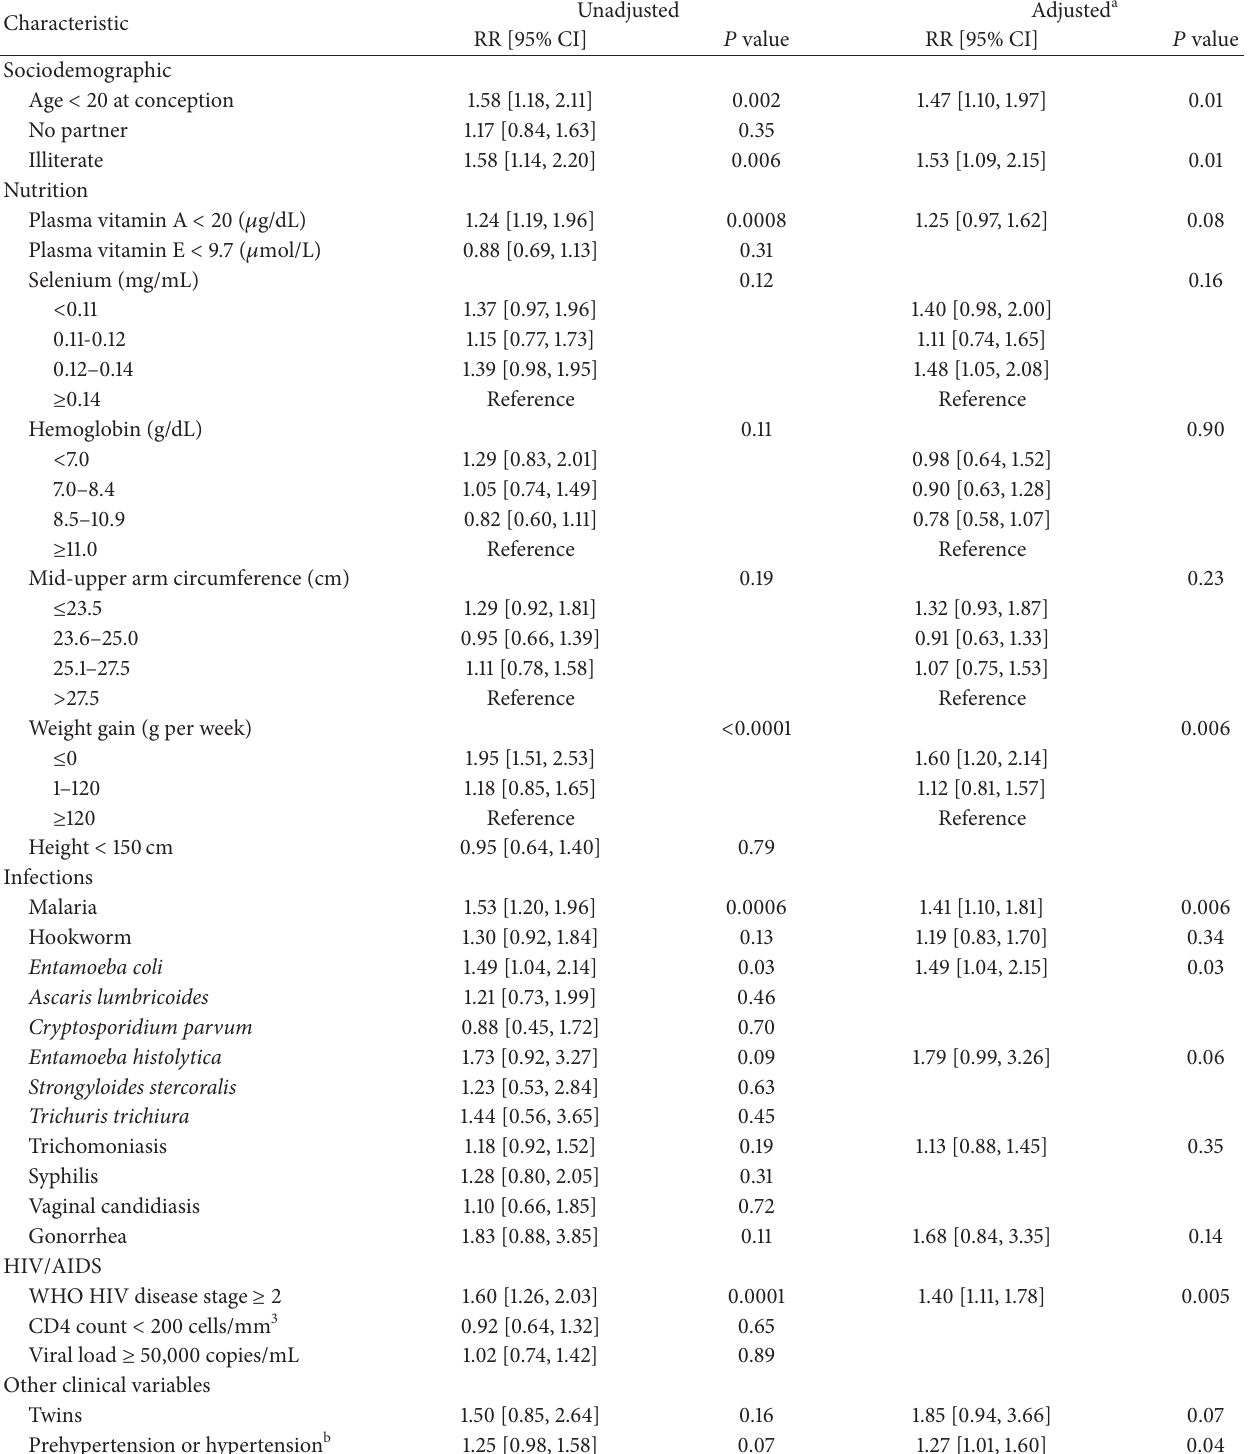
Table 2: Risk factors for preterm birth ( < 37 weeks versus ≥ 37 weeks), 𝑁 = 927